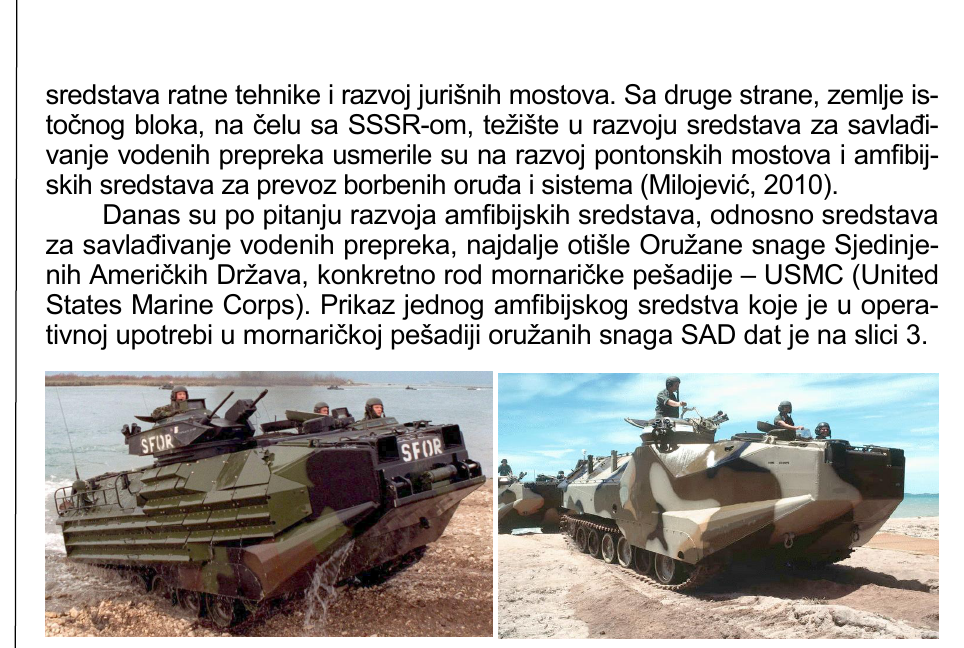
Figure 3 – Amphibious assalt vehicle